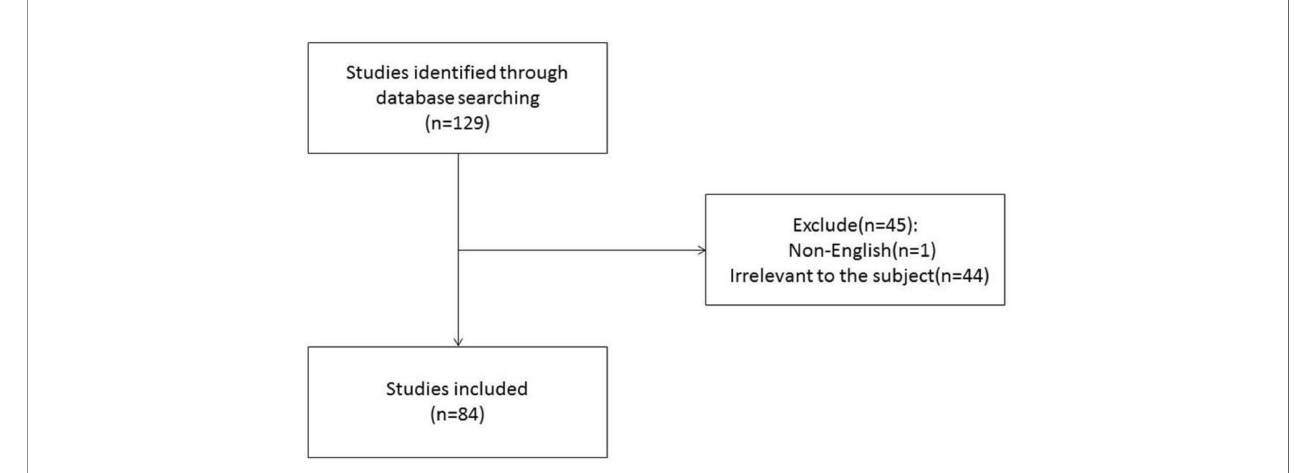
FIGURE 1 | Flow diagram of study